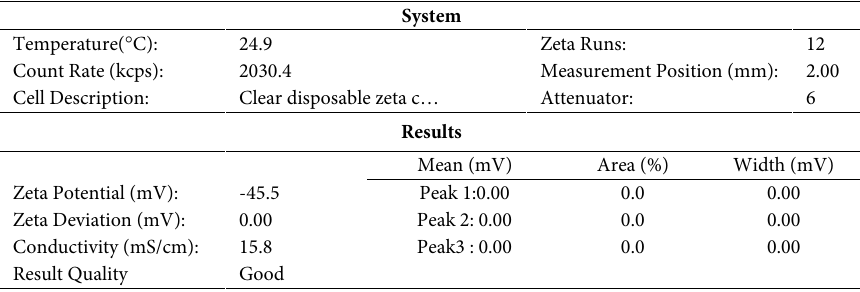
Table 2. IC 50 values of base and nanoliposomal extract of E. elaterium on gastric cancer cell line after 24